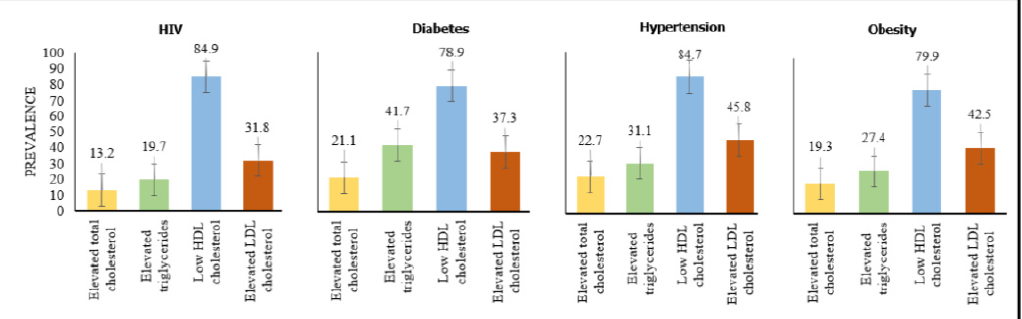
Figure 7. Pooled prevalence of dyslipidaemia in participants with HIV, diabetes, hypertension, and obesity. The cutoff for elevated total cholesterol was >6.18 mmol/L, elevated triglycerides were ≥ 2.3 mmol/L, reduced HDL cholesterol was <1 mmol/L, and elevated LDL was ≥ 4.1mmol/L.